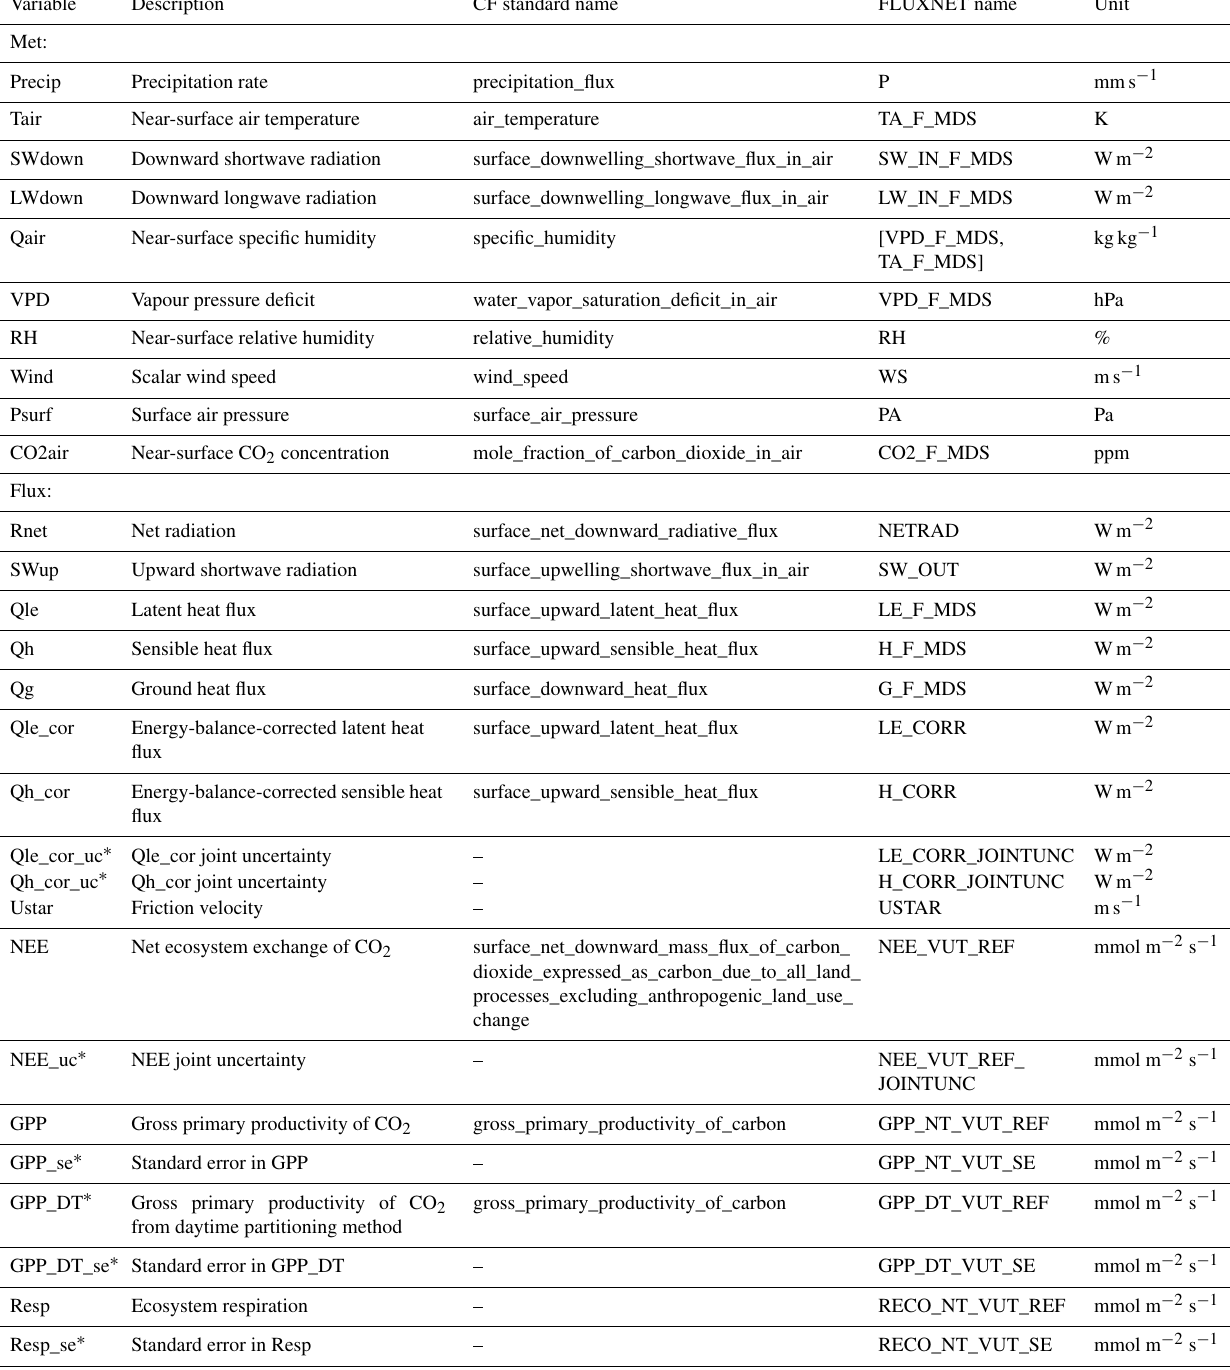
Table 1. Variables provided in the final dataset (please note not all sites provide all flux variables). Variable naming conventions fol- low the ALMA format where available. FLUXNET variable derivation details can be found at